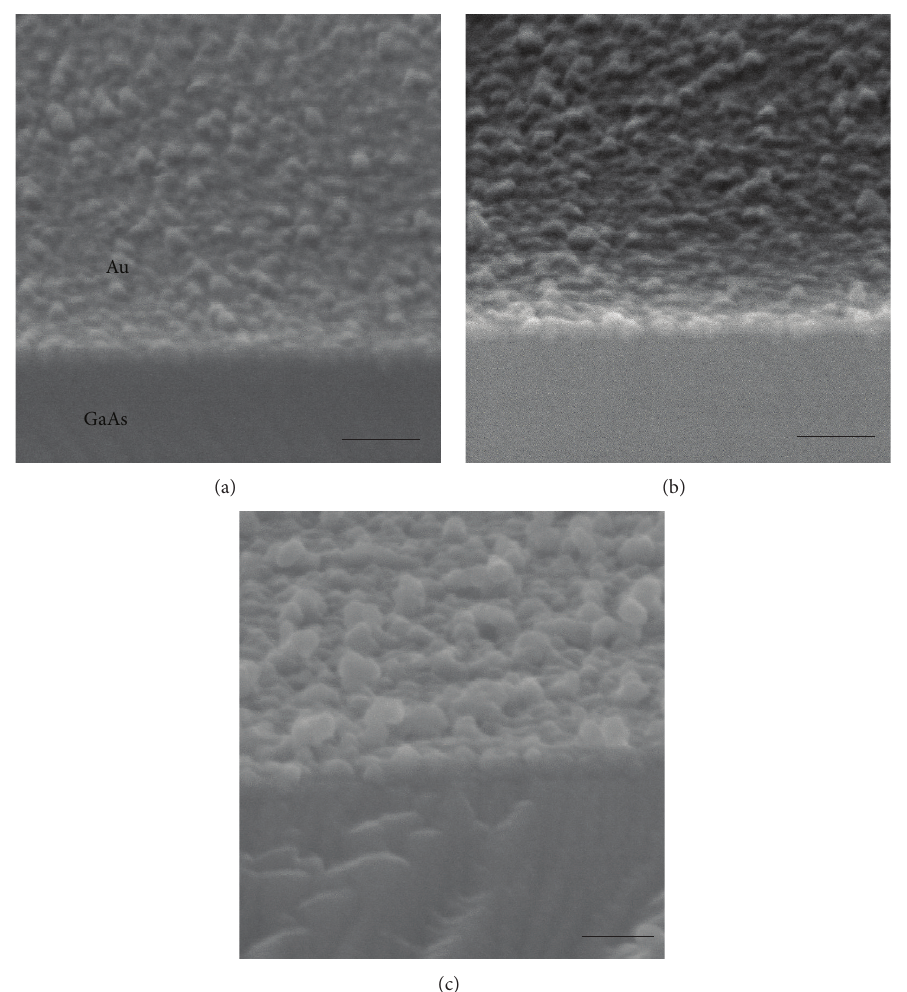
Figure 6: Cross-sectional scanning electron microscope (SEM) image of galvanic displacement process on the GaAs (100) substrate. Cleaned GaAs (100) sample is immersed in 0.5 mM HAuCl 4 for (a) 1min, (b) 2 min, and (c) 10 min. Scale bars are 90 nm.